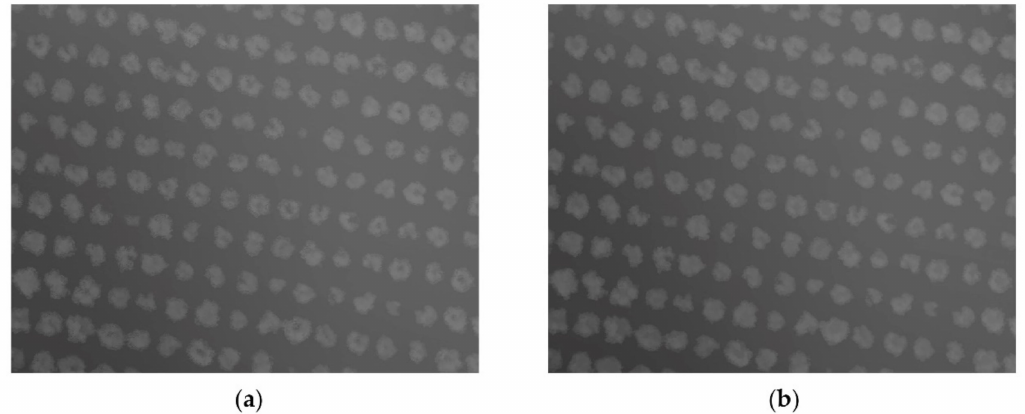
Figure 6. Filling gaps illustration: ( a ) same zoomed area of GS DMS shown in Figure 5; ( b ) result of the filling gaps operation applied to ( a